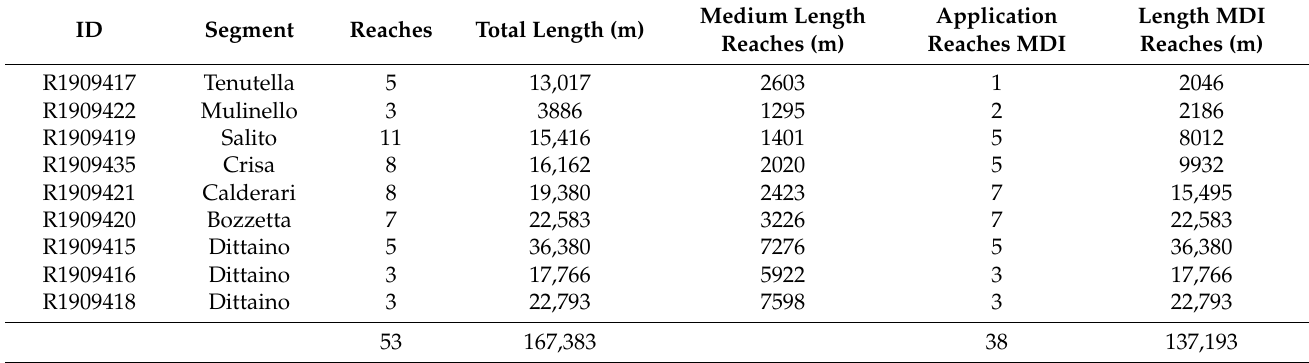
Table 8. Number of reaches (and their lengths) used for the calculation of MDI in the Dittaino